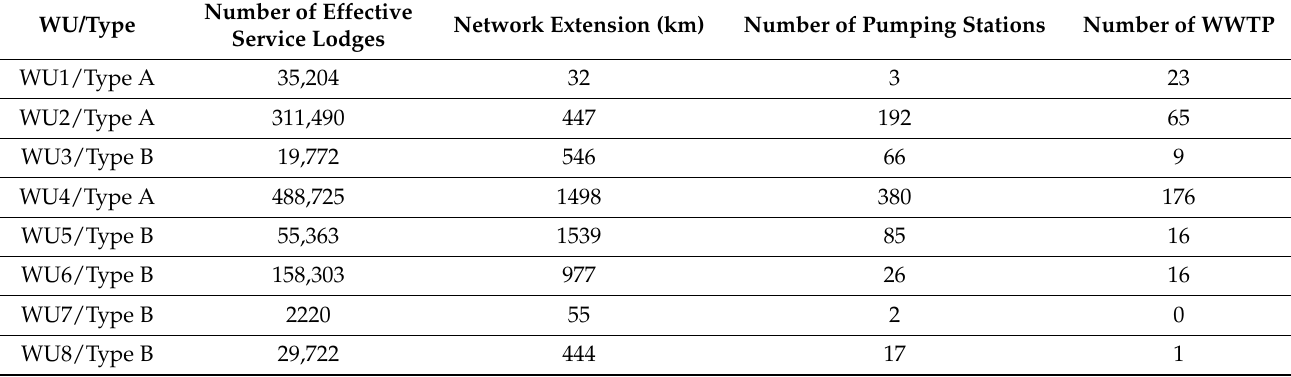
176. Table 1 summarizes the global characterization of the utilities. Data were supplied for the reference period of 2015 to 2019, whenever available. Table 1. Global characterization of the selected wastewater utilities